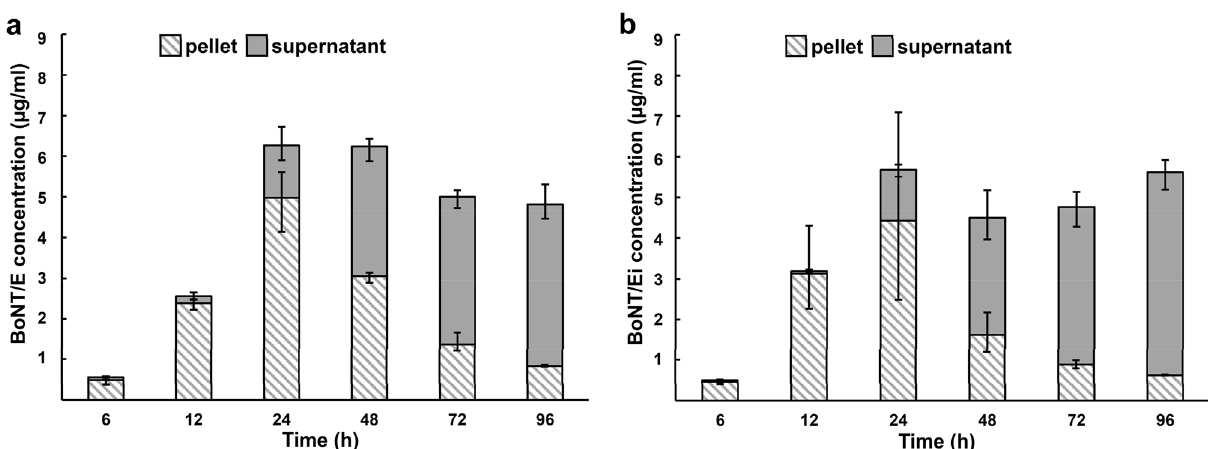
Figure 2. BoNT/E and BoNT/Ei concentrations and distribution in Clostridium botulinum Beluga wild-type (Beluga WT) ( a ) and Beluga Ei ( b ) cultures determined with BoNT/E-directed sandwich enzyme-linked immunosorbent assay (ELISA). Error bars indicate the highest and the lowest concentrations measured of the three parallel biological